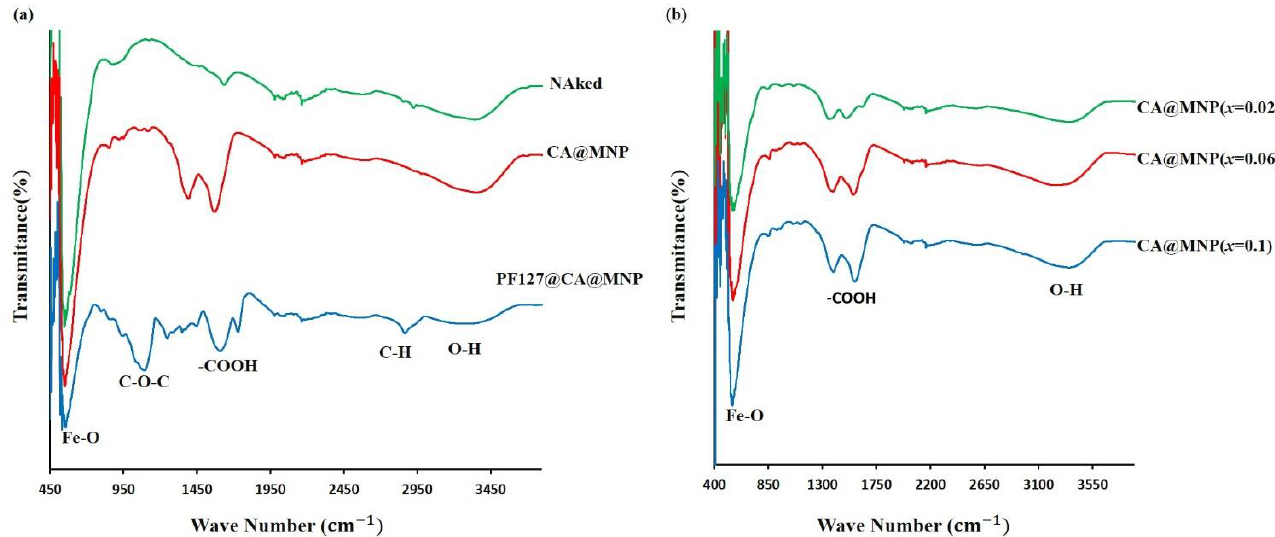
Figure 5. Fourier-transform infrared spectra of ( a ) naked, citric acid and pluronic F-127 coated MZF and ( b ) Eu-substituted MZF ( x = 0.02, 0.06, 0.10). and ( b ) Eu-substituted MZF ( x = 0.02, 0.06,